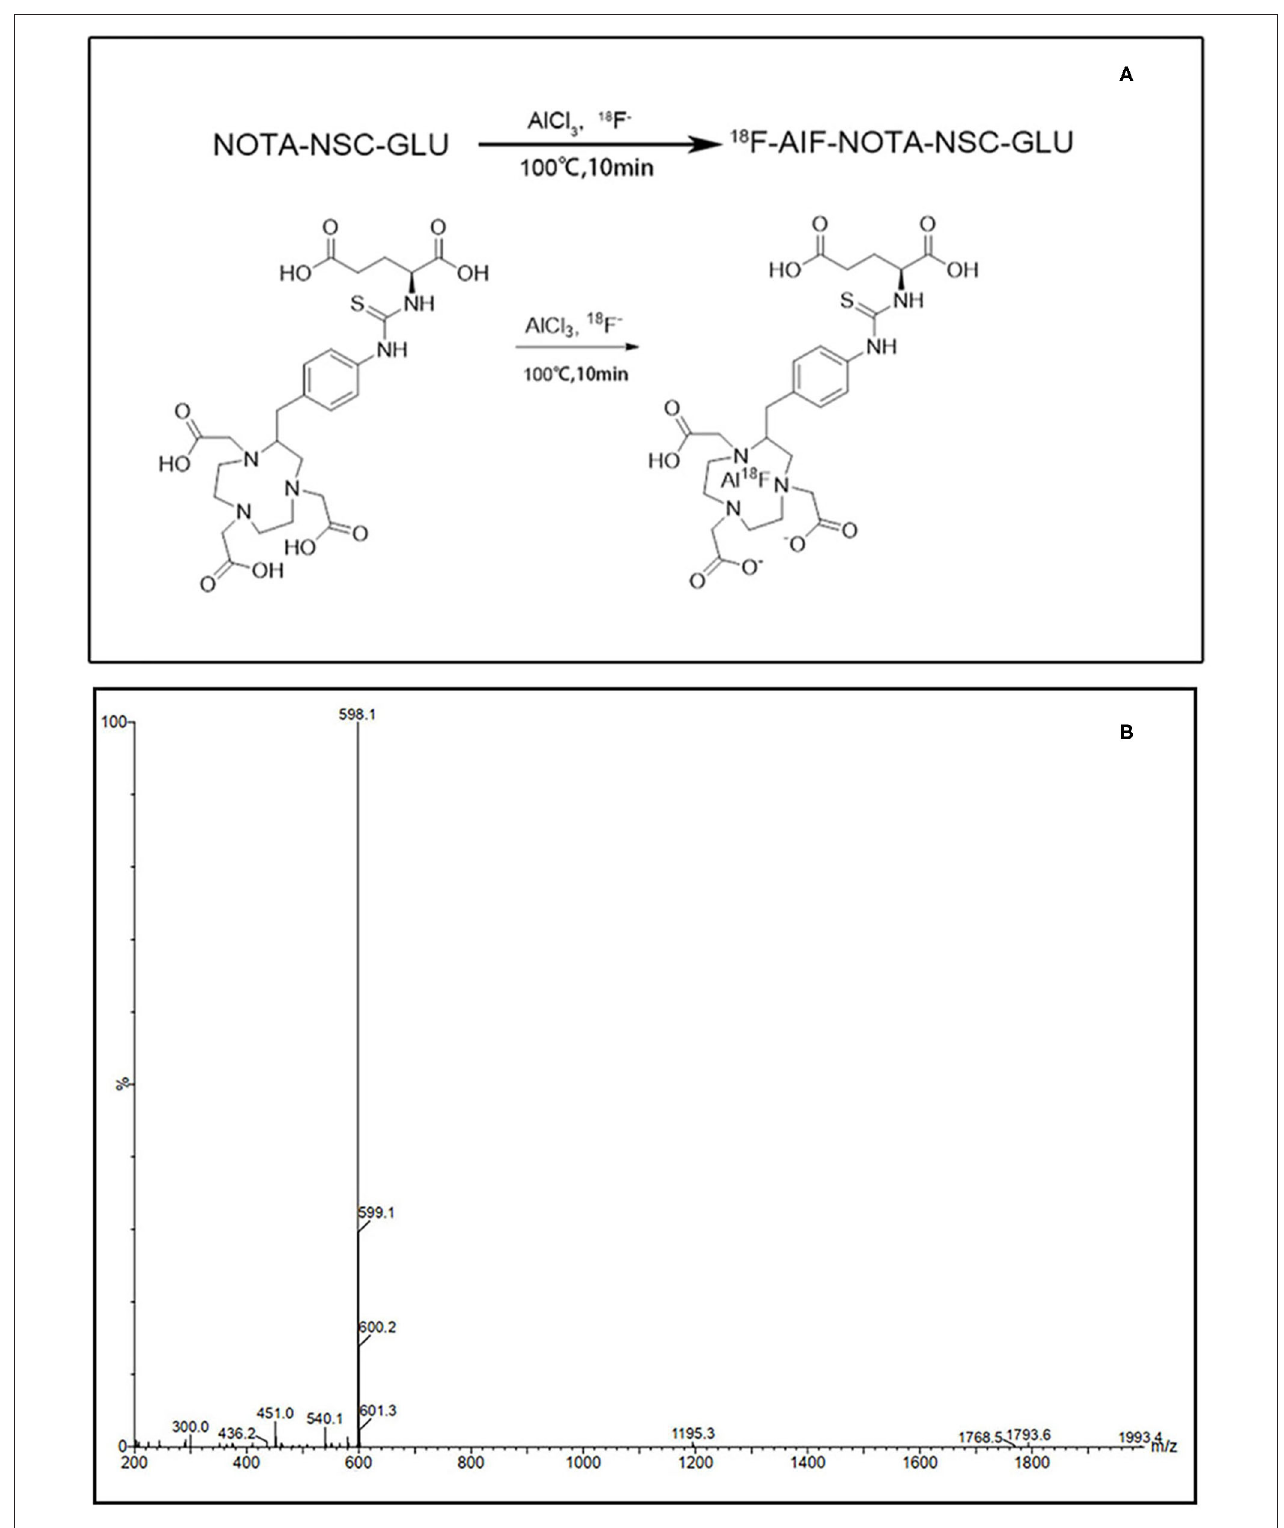
FIGURE 1 | The synthetic scheme and MS spectra of [ 18 F]AlF-NOTA-NSC-GLU. (A) The synthetic scheme of [ 18 F]AlF-NOTA-NSC-GLU. (B) The MS spectra of [ 18 F]AlF-NOTA-NSC-GLU. [ 18 F]AlF-NOTA-NSC-GLU, [ 18 F]-aluminum-fluoride-1,4,7-triazacyclononane-1,4,7-triacetic-acid-2-S-(4-isothiocyanatobenzyl)-l-glutamate.